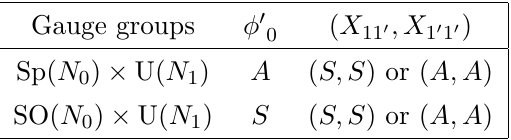
Table 13. The orientifold projection (cid:10) of the SPP. \A" stands for \Antisymmetric representation", while \S" for \Symmetric